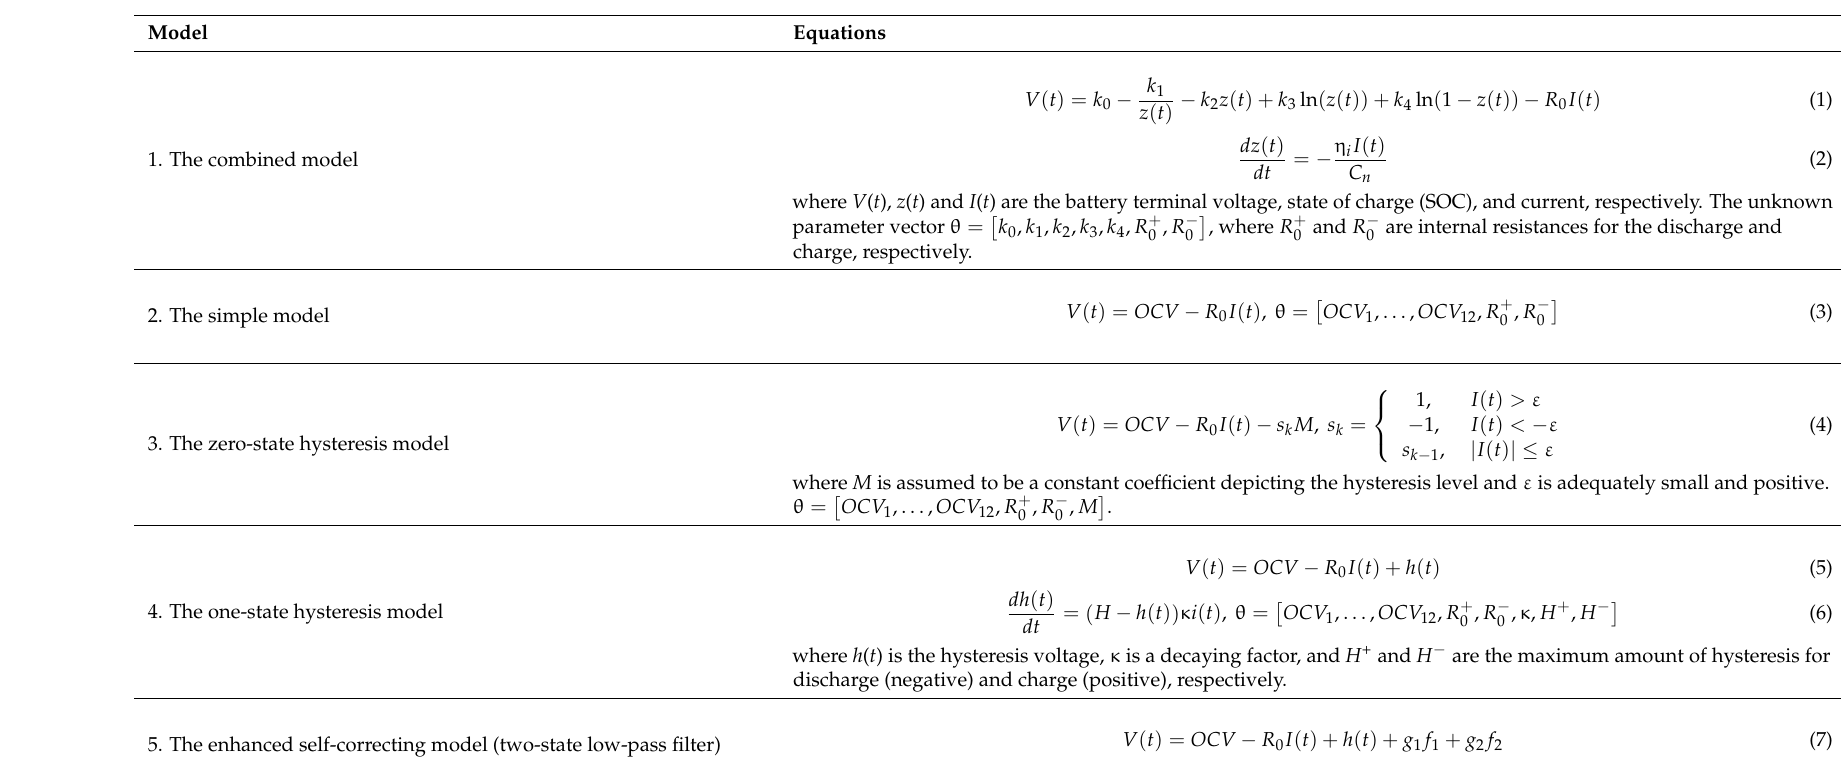
Table 1. Twelve ECM model